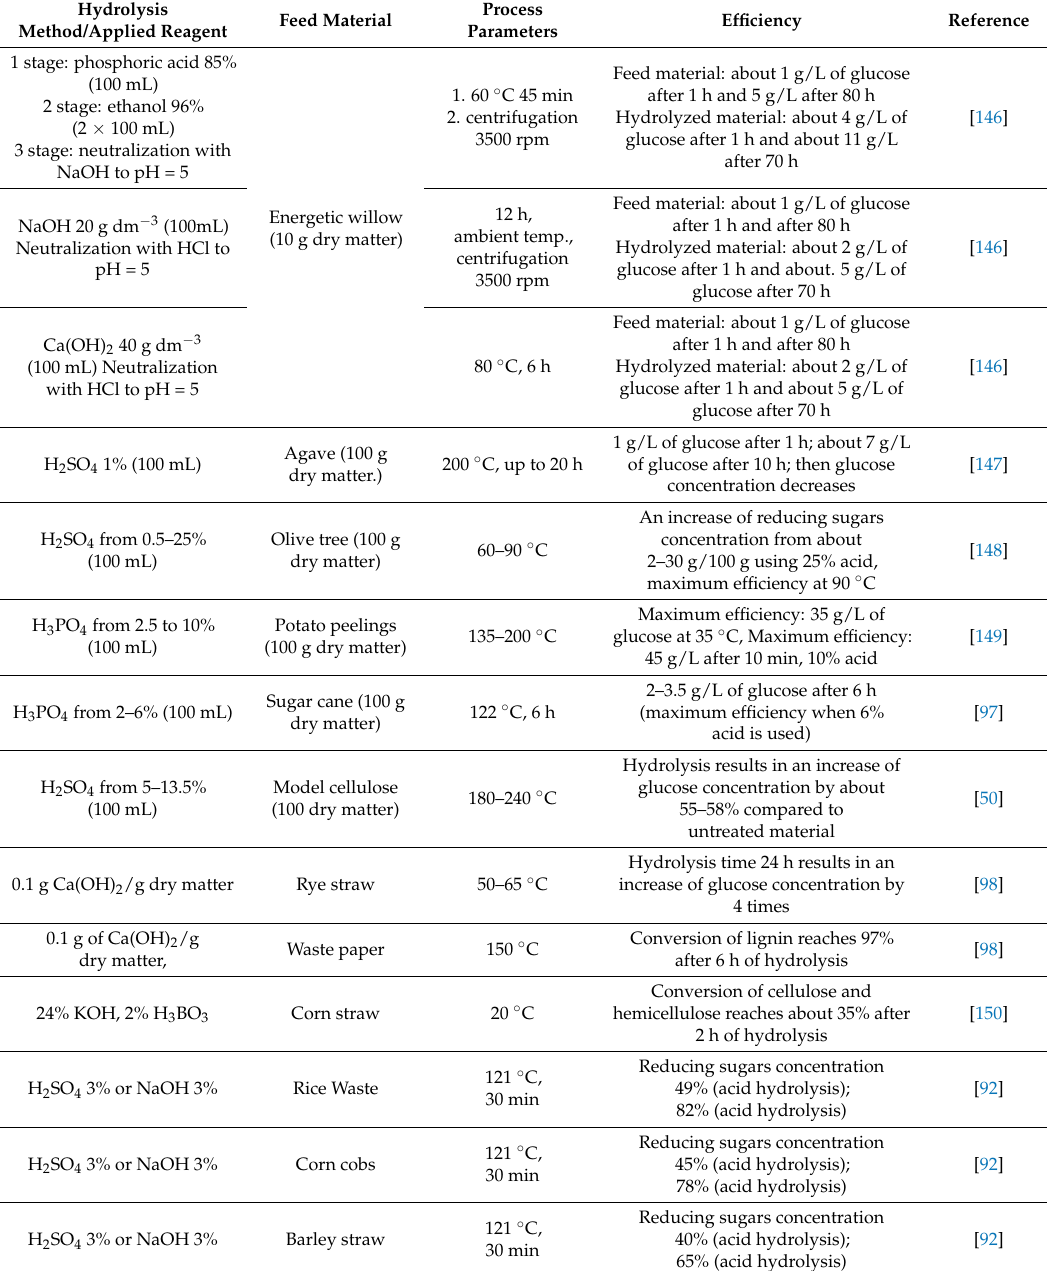
Table 4. Process parameters and efficiency of selected chemical methods of